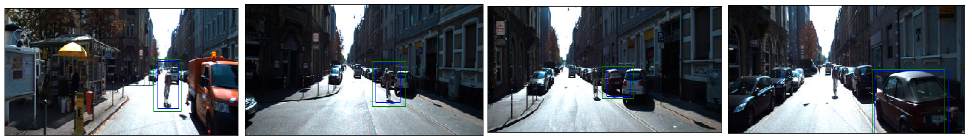
Figure 1. The hierarchical attentive recurrent tracking (HART) [3] algorithm failed to track the cyclist when the color of the background was similar to the foreground in the KITTI dataset [14].